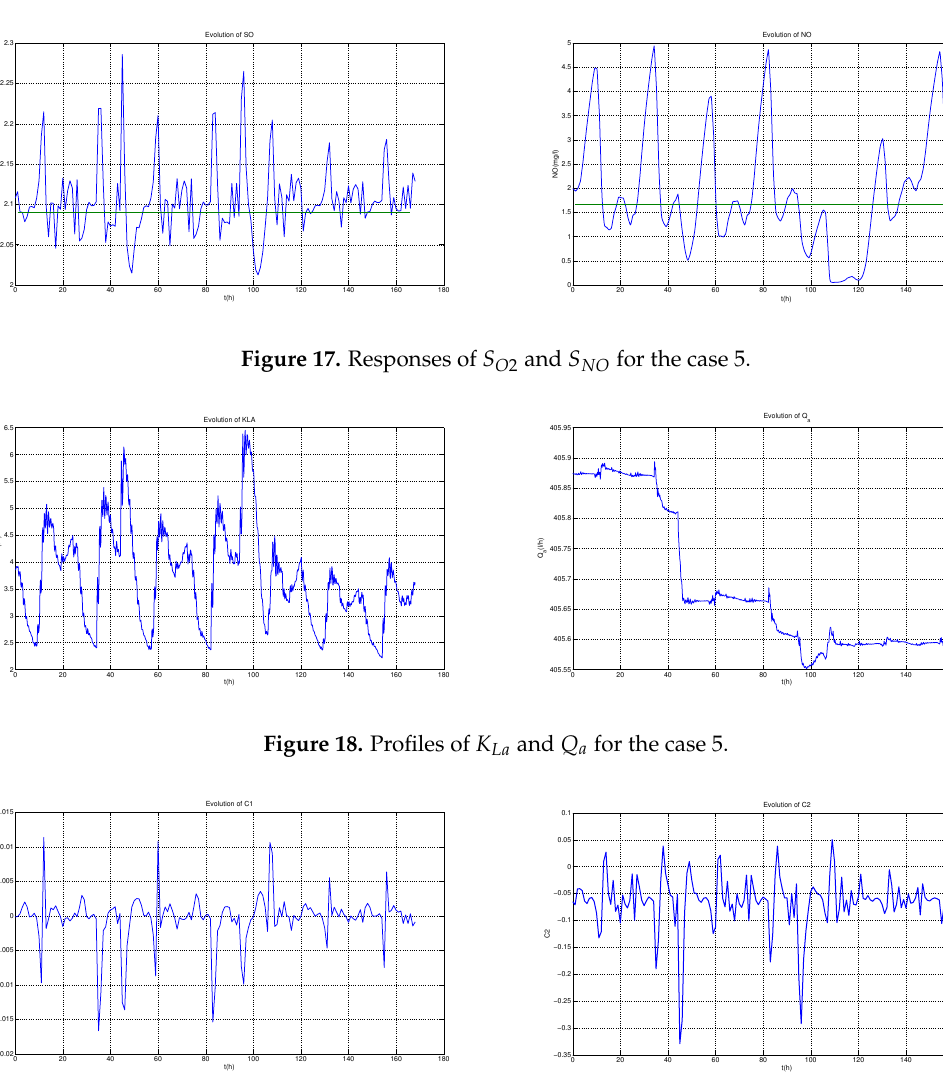
Figure 16. Evolution of the degree of freedom c 2 : (left) case3; (right) case 4.